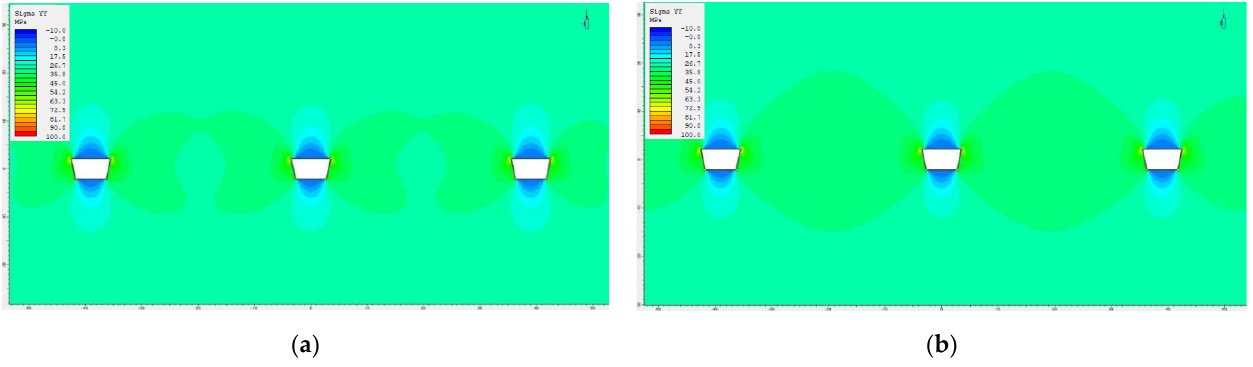
( b ) Figure 6. Distribution of σ YY stresses in the cross-section through ramps drilled in sandstone: ( a ) view of both headings; ( b ) close-up of a single excavation. ( a ) ( b ) Figure 7. Distribution of σ YY stresses in the cross-section through ramps drilled in dolomite: ( a ) view of both headings; ( b ) close-up of a single excavation.